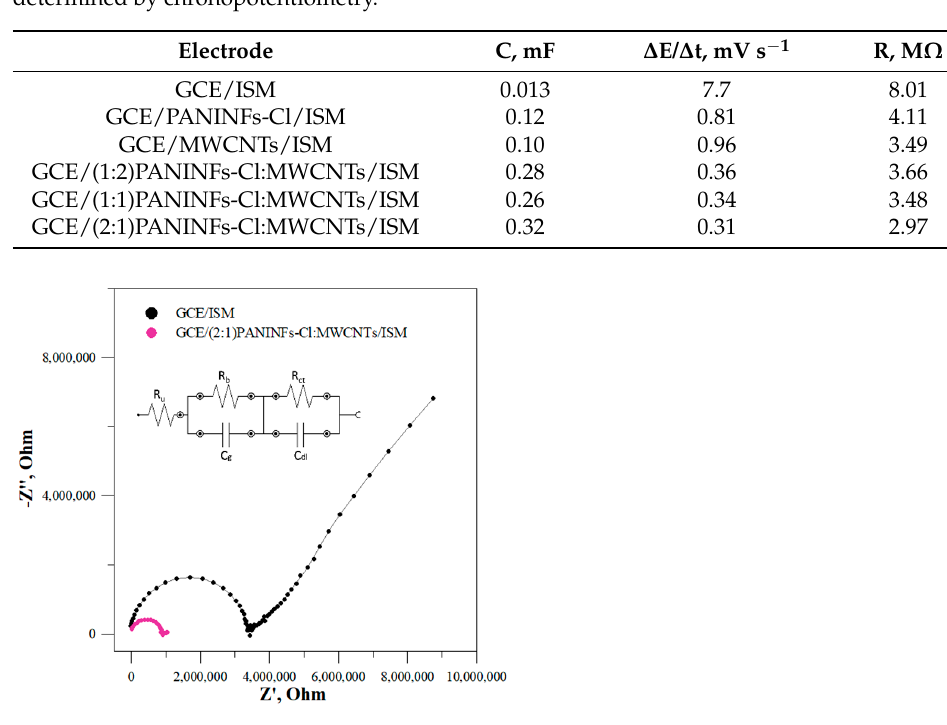
Figure 5. Impedance spectra for GCE/ISM and GCE/(2:1)PANINFs-Cl:MWCNTs/ISM measured in 10 − 1 mol L − 1 NaCl and equivalent circuit (solid lines represent data fits, the error of the fits χ 2 was 0.056 for GCE/ISM and 0.012 for GCE/(2:1)PANINFs-Cl:MWCNTs/ISM).